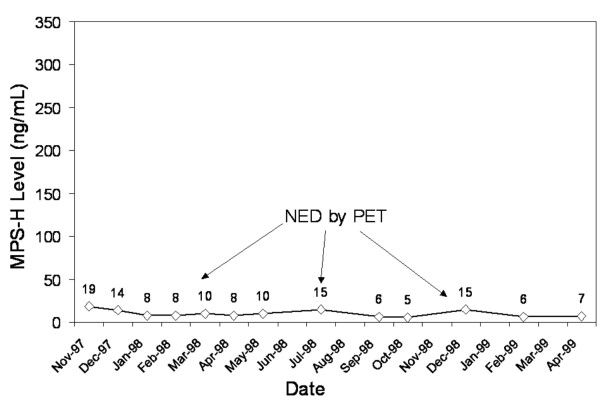
Patient followed for 24 months without evidence of recurrence on physical exam, endoscopy, or FDG-PET.